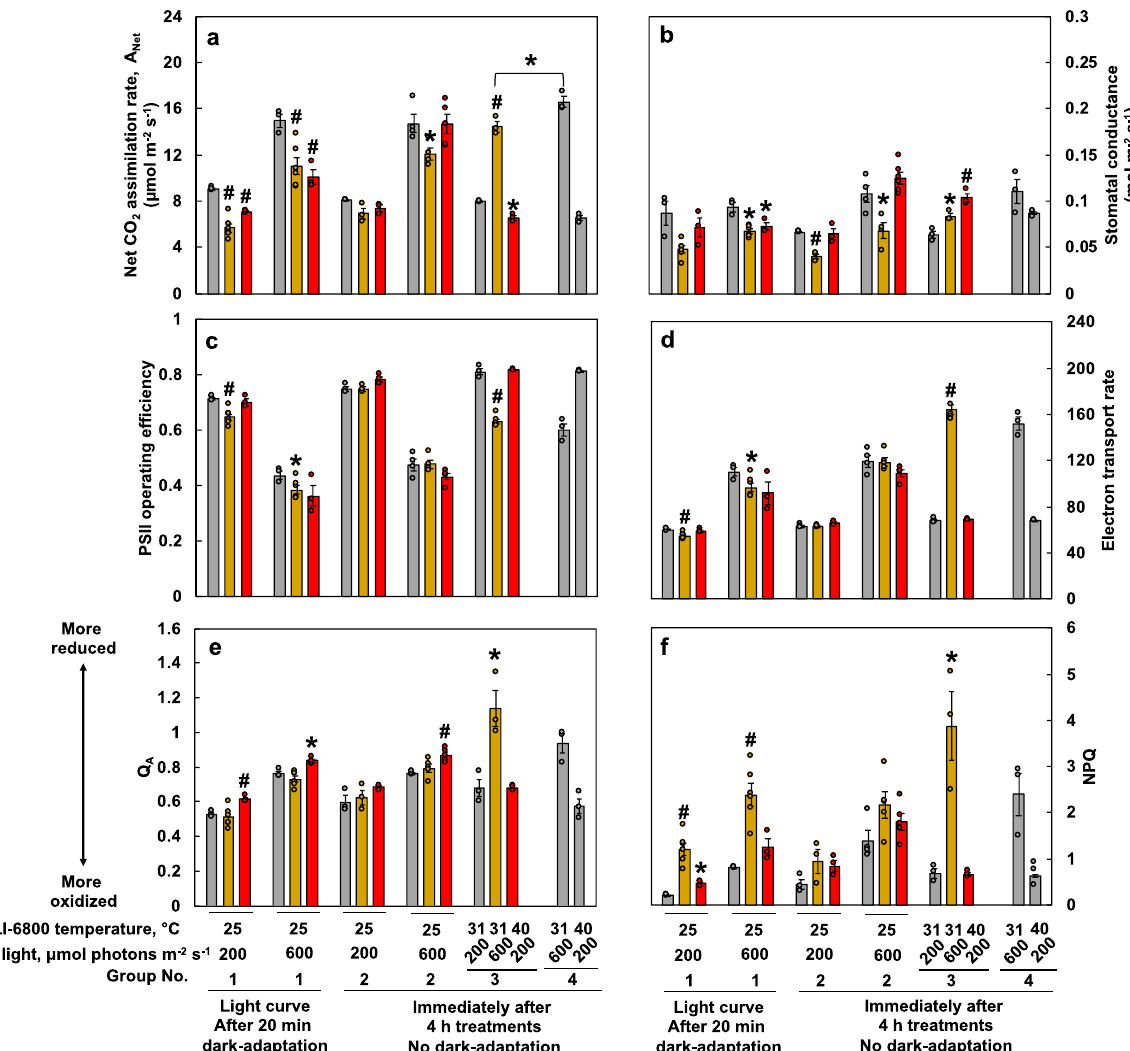
Fig. 8 High-light- or high-temperature-treated leaves had lower photosynthetic capacities than leaves treated with the control condition. After S. viridis plants were treated with 4 h of control condition (ctrl_4h) or high light (HL_4h) or high temperature (HT_4h), photosynthetic parameters in treated leaves were monitored using LI-6800. Group 1 are select data from the light response curves after 20 min dark-adaptation with indicated light and temperature. Groups 2, 3, and 4 were measured immediately after 4 h of control, high light, high temperature treatments without dark-adaptation and under the indicated temperature and light condition. a Net CO 2 assimilation rates. b Stomatal conductance. c PSII operating ef fi ciency. d Electron transport rate. e Plastoquinone redox status (Q A ). f NPQ, Non-photochemical quenching. Values are mean ± SE, n = 3 – 6 biological replicates. Asterisk and pound symbols indicate statistically signi fi cant differences of HL_4h and HT_4h leaves compared to ctrl_4h leaves in the same group or under the same condition using Student ’ s two-tailed t -test with unequal variance ( * 0.01 < p < 0.05, # p <